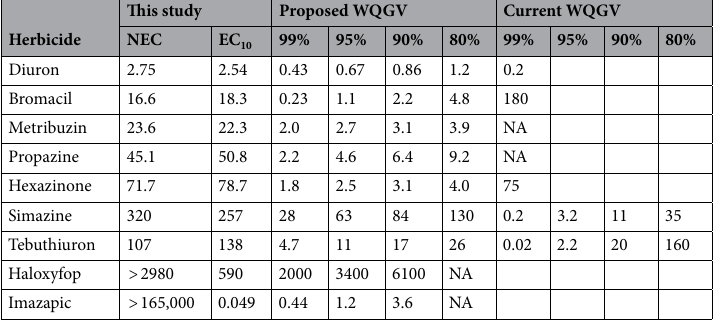
Table 5. Comparison of toxicity thresholds derived here vs Australian WQGVs. Comparisons of toxicity thresholds of EC 10 and NEC for specific growth rate (SGR) of Cladocopium goreaui in response to nine herbicides with current guideline values 41 and proposed guideline values 39,42,43 derived for 99, 95, 90 and 80% species protection (PC99, PC95, PC90, PC80 respectively). All concentrations are in µg L −1 . NA denotes no current